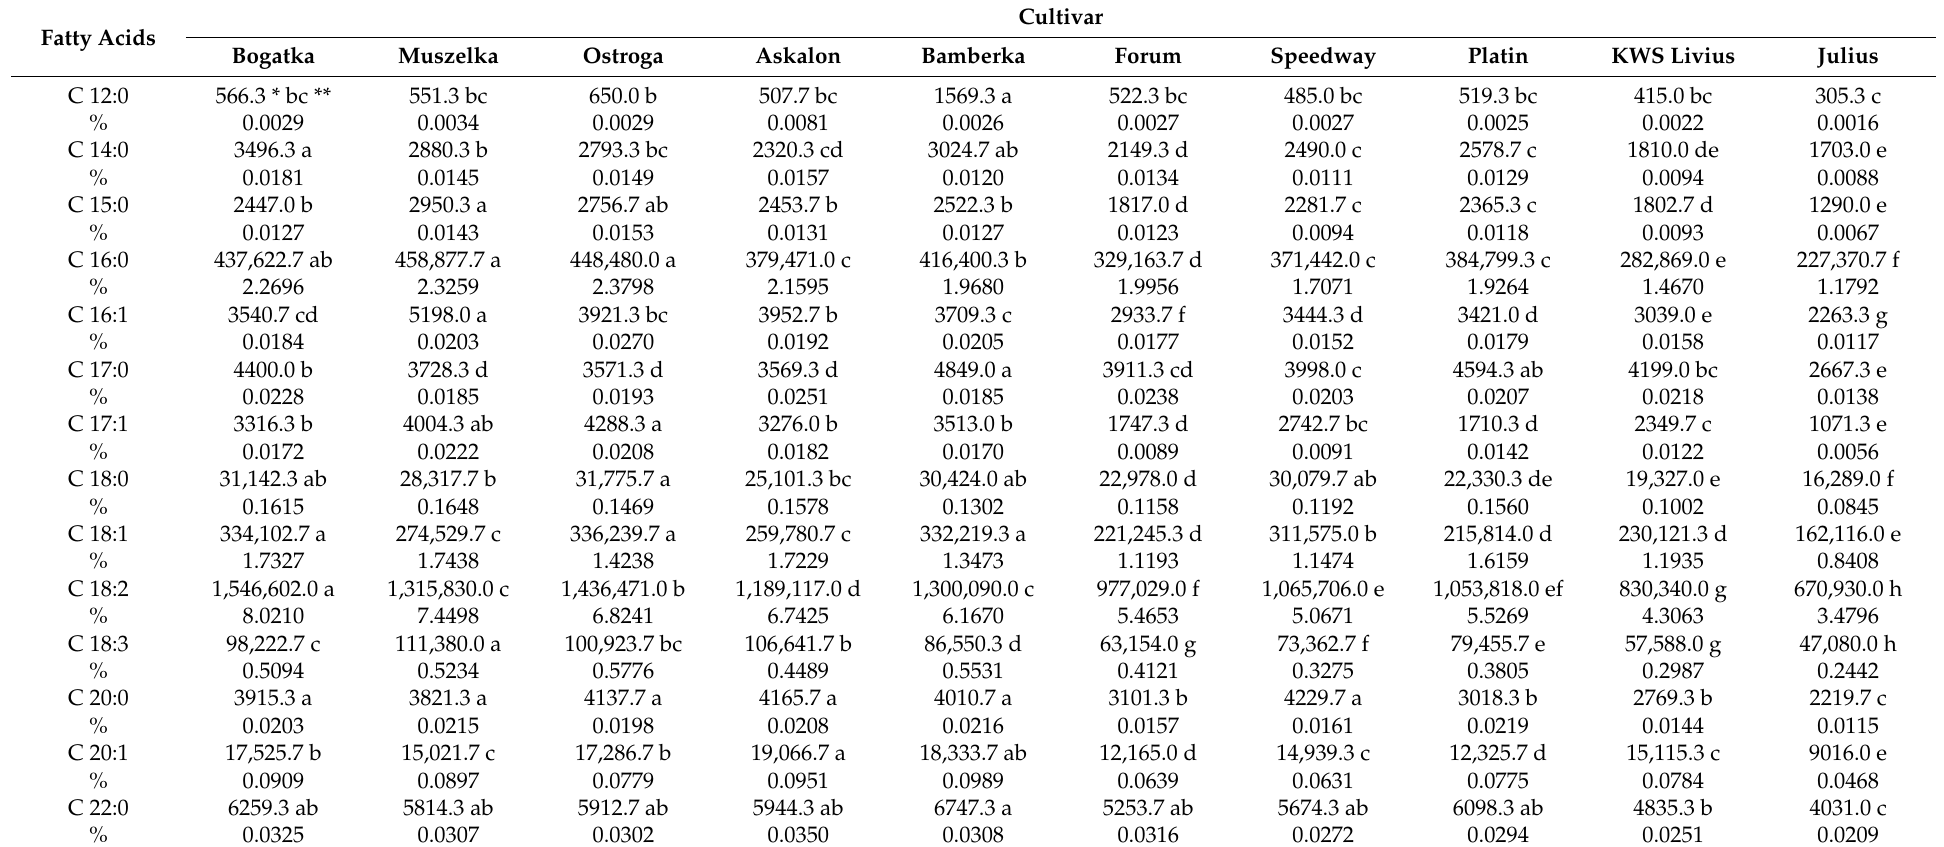
Table 3. The mean content and % of fatty acids in kernels of the analysed wheat